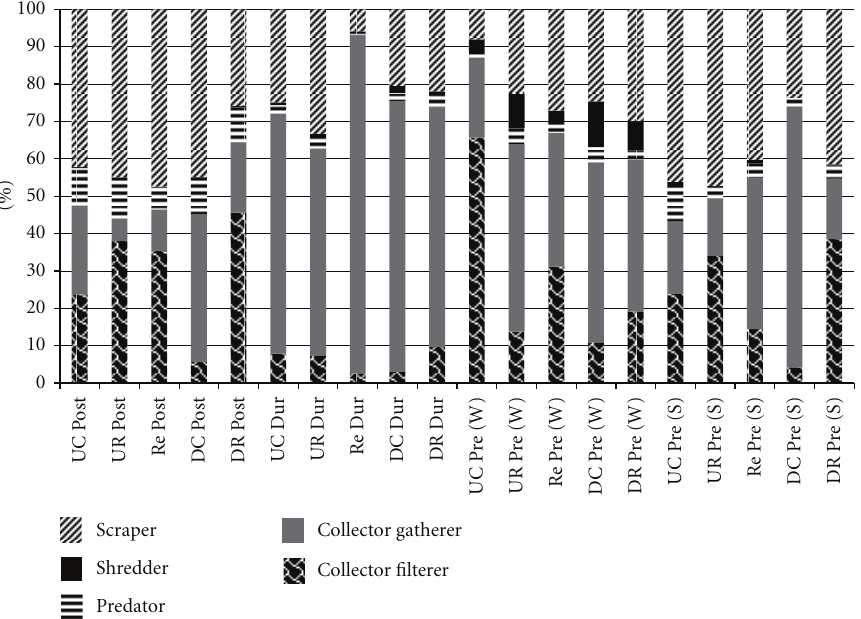
Figure 3: Proportions of functional feeding groups present at each reach in the Cacapon River, WVa, USA during each sampling season. Upstream control (impaired reach, but not receiving restoration) denoted “UC”, downstream control denoted “DC”, upstream reference (unimpaired, natural reach) denoted “UR”, and downstream reference denoted “DR”. The restoration reach is denoted as “Re”. “Post” refers to postrestoration samples (2010), “Dur” refers to during restoration samples (2010), and “Pre” refers to prerestoration samples from summer 2009 (S) and winter 2010